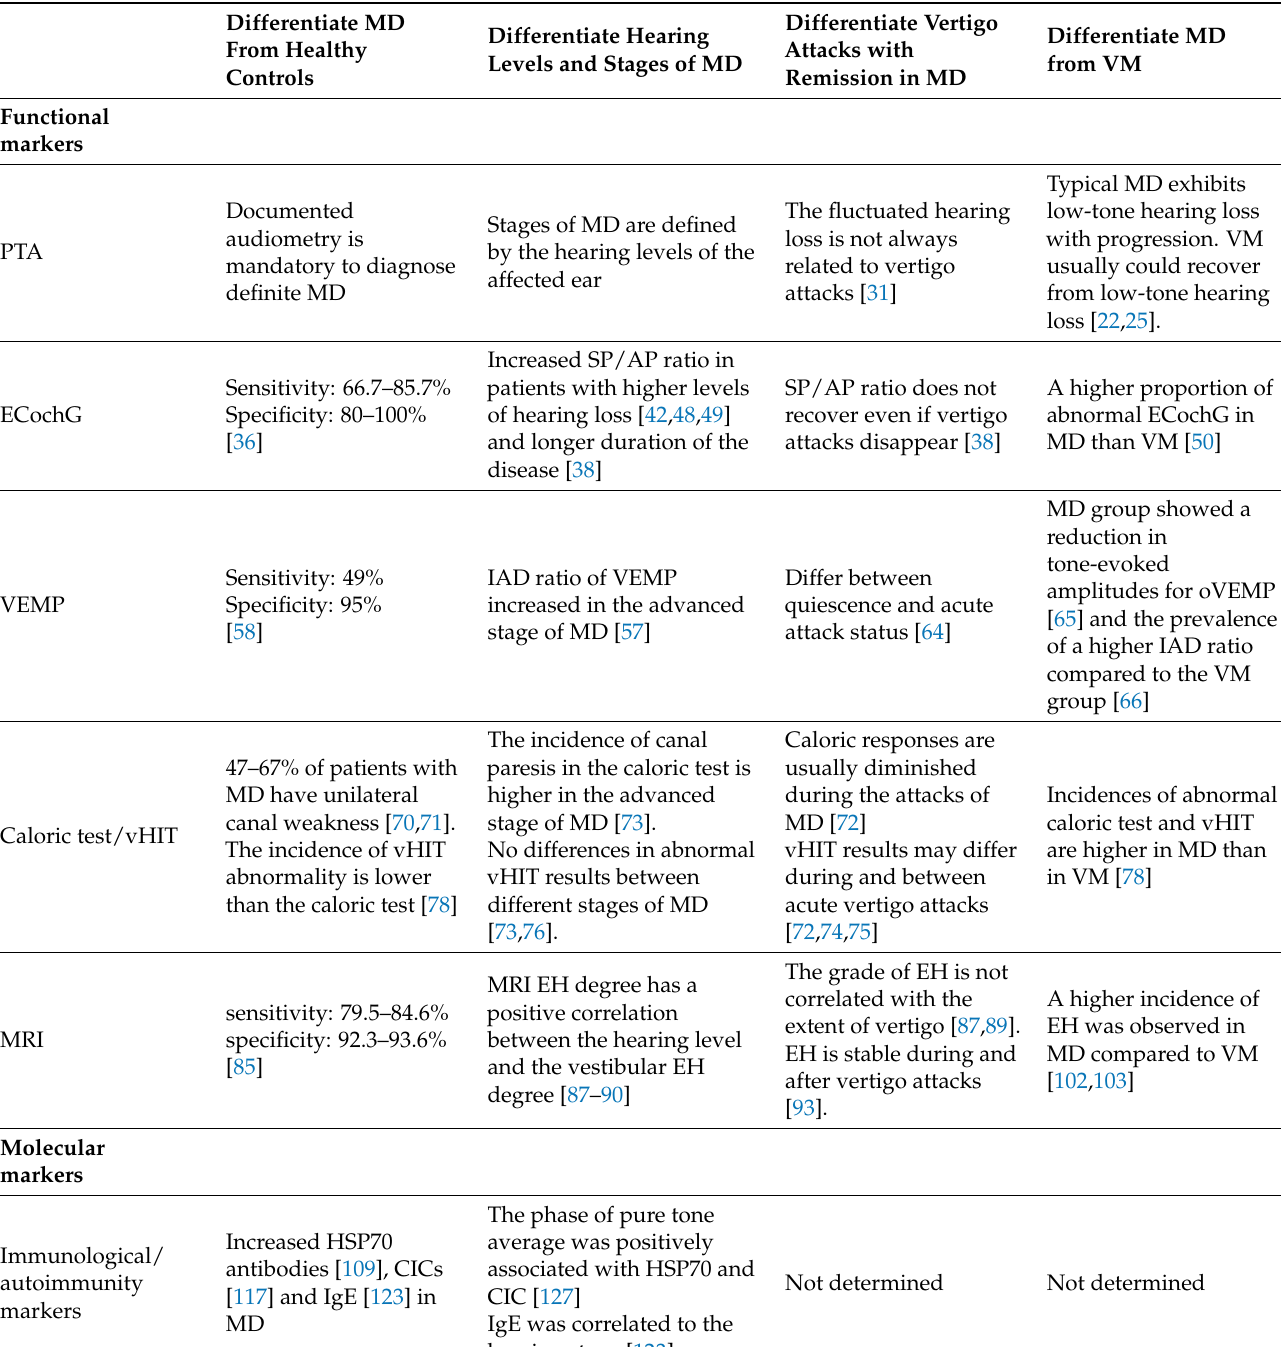
Table 2. Summary of functional and molecular markers for